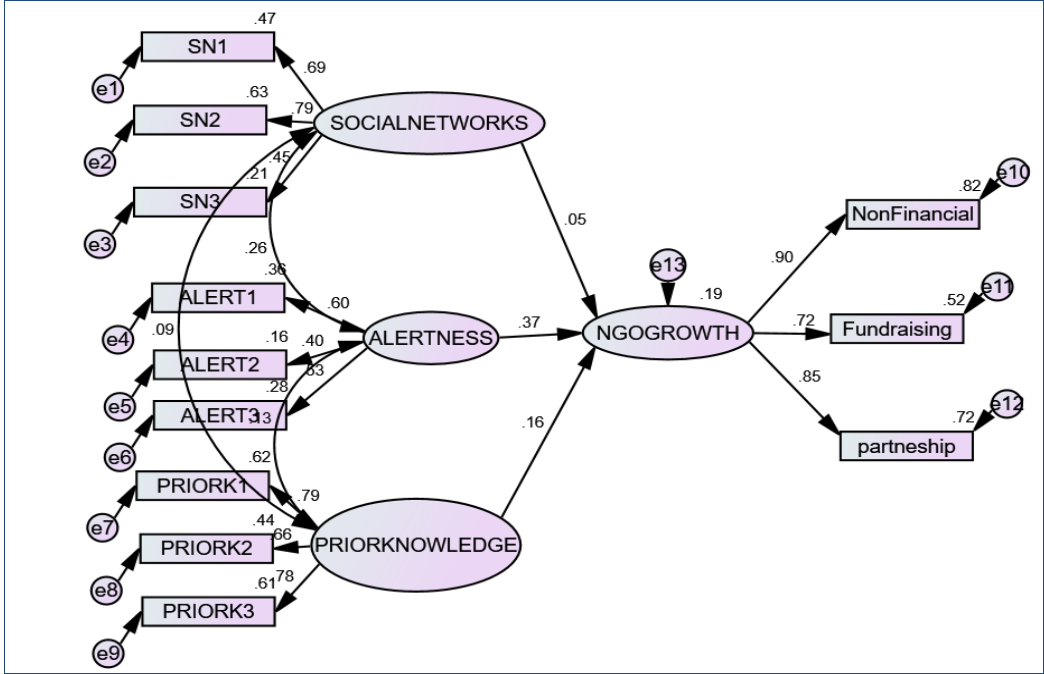
Figure 2: Path diagram to test the influence of the relationship between entrepreneurial opportunity discovery dimensions and growth